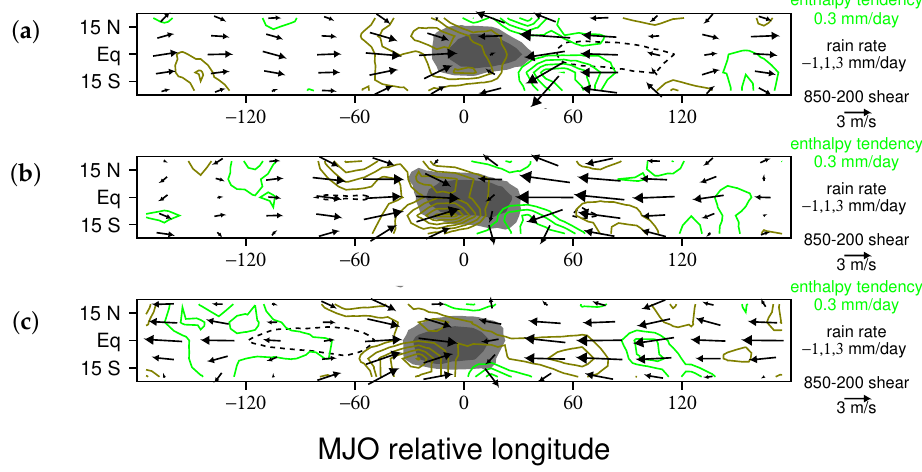
Figure 10. Moist enthalpy tendency owing to advection for the developing, mature, and dissipating stages ( a – c ). Green contours indicate moistening and/or heating, and brown contours indicate drying and/or cooling. Vectors show the difference between 850 and 200 hPa flow. Regions with rainfall greater than 1 and 3 mm/day are shaded light and dark gray, respectively. The − 1 mm/day rainfall contour is marked with a dashed